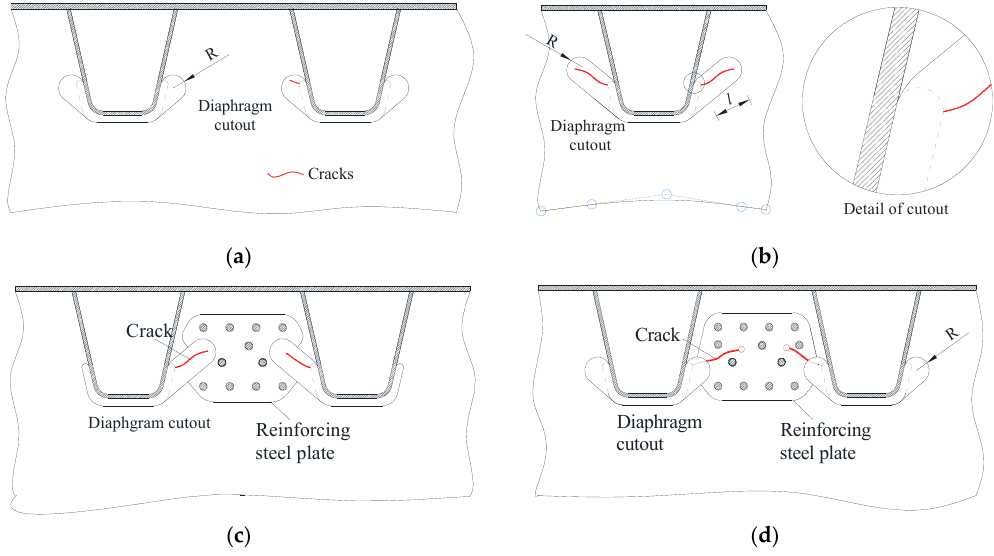
Figure 4. Repair schemes for diaphragm cutouts: for short cracks using ( a ) Scheme 1; for long cracks using ( b ) Scheme 2, ( c ) Scheme 3 and ( d ) Scheme 4.